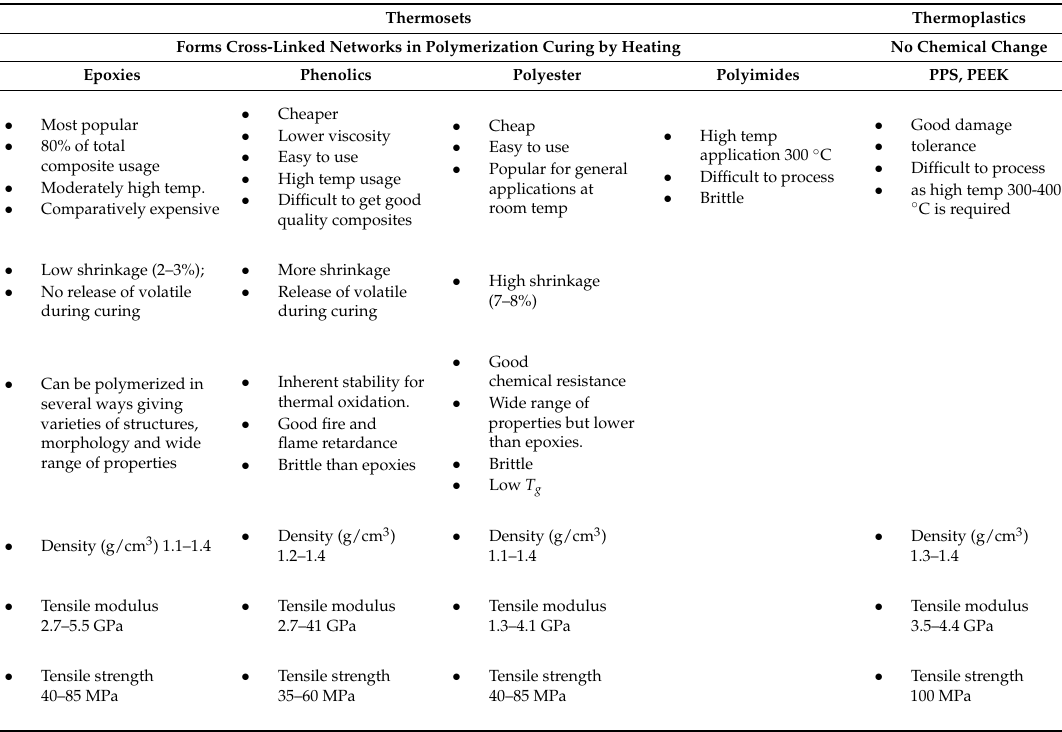
Table 1. Table of polymeric matrices commonly employed in aerospace sector (Reprinted by permission from Nature/Springer/Palgrave from Ref. [101]). PPS: polyphenylene sulfide; PEEK: polyether ether ketone. Thermosets Thermoplastics Forms Cross-Linked Networks in Polymerization Curing by Heating No Chemical Change Epoxies Phenolics Polyester Polyimides PPS,